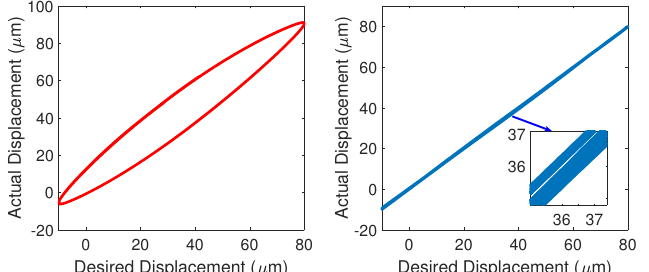
Figure 17. Hysteresis loops in 30 rad/s generated with open-loop status ( left ) and closed-loop status via the proposed strategy ( right